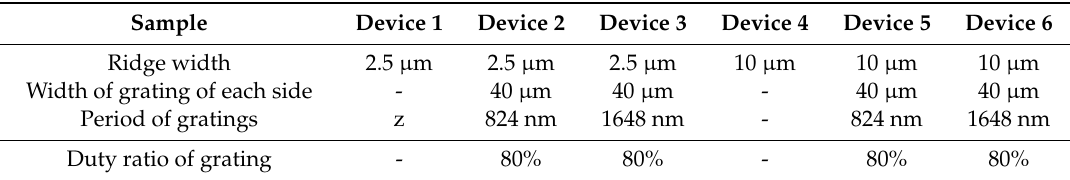
Table 1. The structure parameters of the fabricated distributed feedback laser diodes (DFB-LDs) of surface gratings and Fabry–Pérot (F–P) LDs.